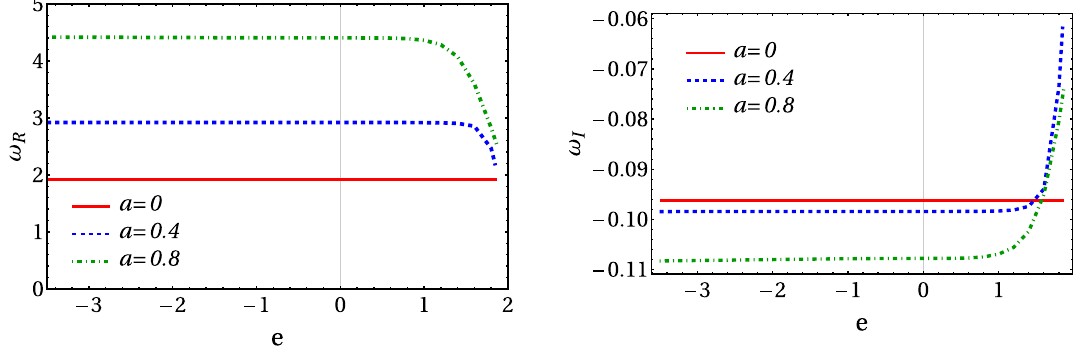
Fig. 2 In this figure, we represent the real and imaginary part of the QNM computed analytically in the eikonal limit with (cid:15) = 10. The parameters (cid:10) are taken to be: M = 1, a ∈ { 0 , 0 . 4 , 0 . 8 } , e ∈ ( − 3 − 3 / 1 − a 2 ∗ , 2 ] , and b = 0 .